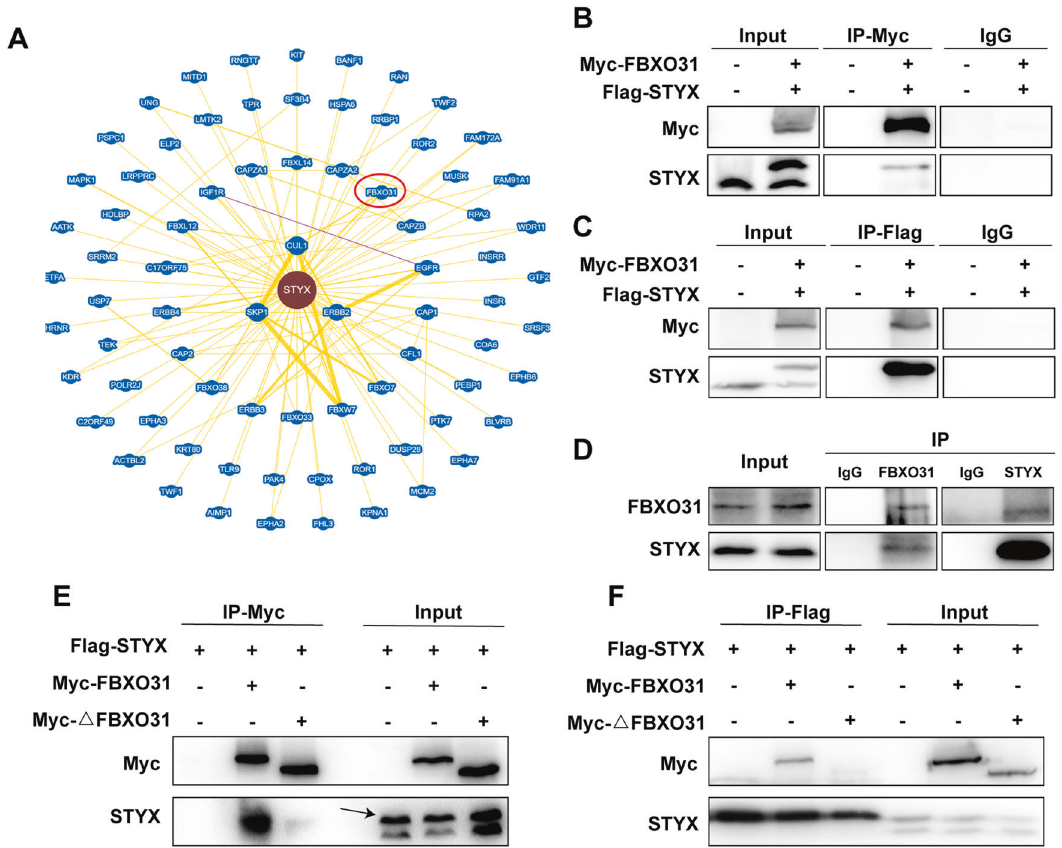
Fig. 5 STYX interacts with FBXO31. A The interaction between STYX and FBXO31 was found through the analysis of Biogrid database (https://thebiogrid.org/). B, C Myc-FBXO31 or Flag-STYX were co-transfected into SGC-7901 cells for 48 h. Co-immunoprecipitation was performed with either Myc antibody to probe for STYX by anti-STYX antibody or Flag antibody to probe for FBXO31 by anti-Myc antibody. Immunoglobulin (IgG) was used as a control. D Endogenous interaction between FBXO31 and STYX protein was detected by co- immunoprecipitation with the FBXO31 or STYX antibody in 293 T cells and western blot were performed to detect the co-precipitated STYX or FBXO31. IgG was used as a control. E, F pCMV or Myc-FBXO31 or Myc-FBXO31 Δ F and Flag-STYX were co-transfected into SGC-7901 cells for 48 h. Co-immunoprecipitation was performed with either Myc antibody to probe for STYX by anti-STYX antibody or Flag antibody to probe for FBXO31 by anti-Myc